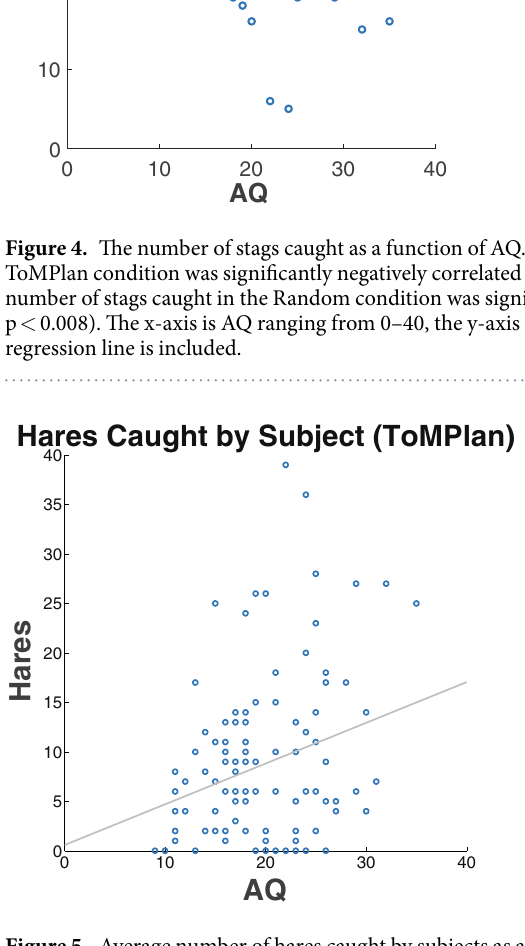
there was a positive correlation between AQ and the number of hares caught during game play with the ToMPlan agent (see Fig. 5; r = 0.264, p < 0.003). High defection rates (i.e., hare hunting) may suggest that high AQ subjects could not interpret the intent of ToMPlan agent 12 , or the possibility that they preferred to systemize rather than mentalize. Furthermore, the tight time constraints of the Stag Hunt game may have played a role in the tendency to utilize a systematic strategy 13 . Together, these findings support the hypothesis that high AQ subjects were less likely to engage in implicit ToM, reminiscent of impairment characteristic of clinical ASD subjects 6 . Individuals with high AQ were less cooperative when faced with a player that had the ability to alter its decisions depending on changing context. In other words, they had trouble discerning the intentions of the agent, which simulated attributes of ToM. Alternatively, these results may suggest that high AQ subjects utilized a more systematic strategy that worked well with the Random agent, but not with the ToMPlan agent, especially under the tight time constraints of the Stag Hunt game.